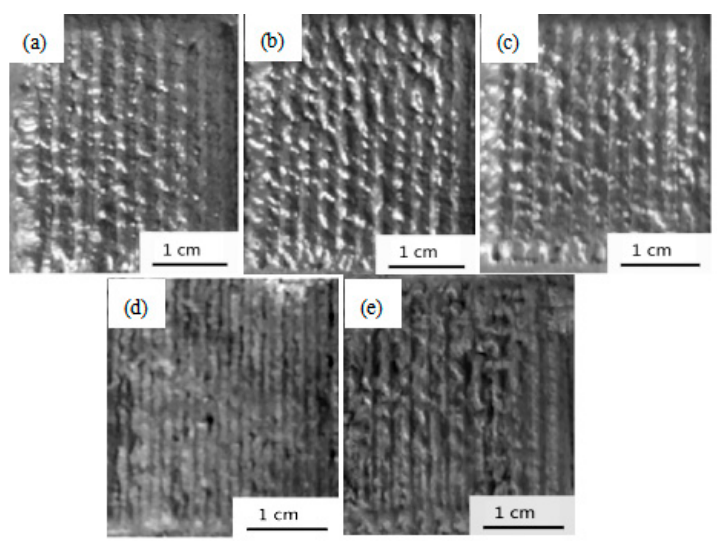
Figure 3. The surface morphology of cladding coating under different laser energy densities. ( a ) 46.67 kJ/cm 2 ; ( b ) 53.33 kJ/cm 2 ; ( c ) 60.00 kJ/cm 2 ; ( d ) 66.67 kJ/cm 2 ; ( e ) 73.33 kJ/cm 2 Table 2. Effect of energy density on the roughness, thickness, and interface of cladding coating.